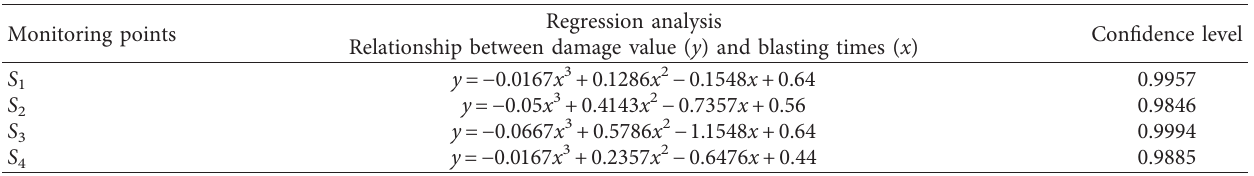
Figure 19: Regression relationship between the blasting damage value of S Table 4: Relationship between the damage value of some unit monitoring points of rock anchor beams perpendicular to the axis of the powerhouse and the blasting times.